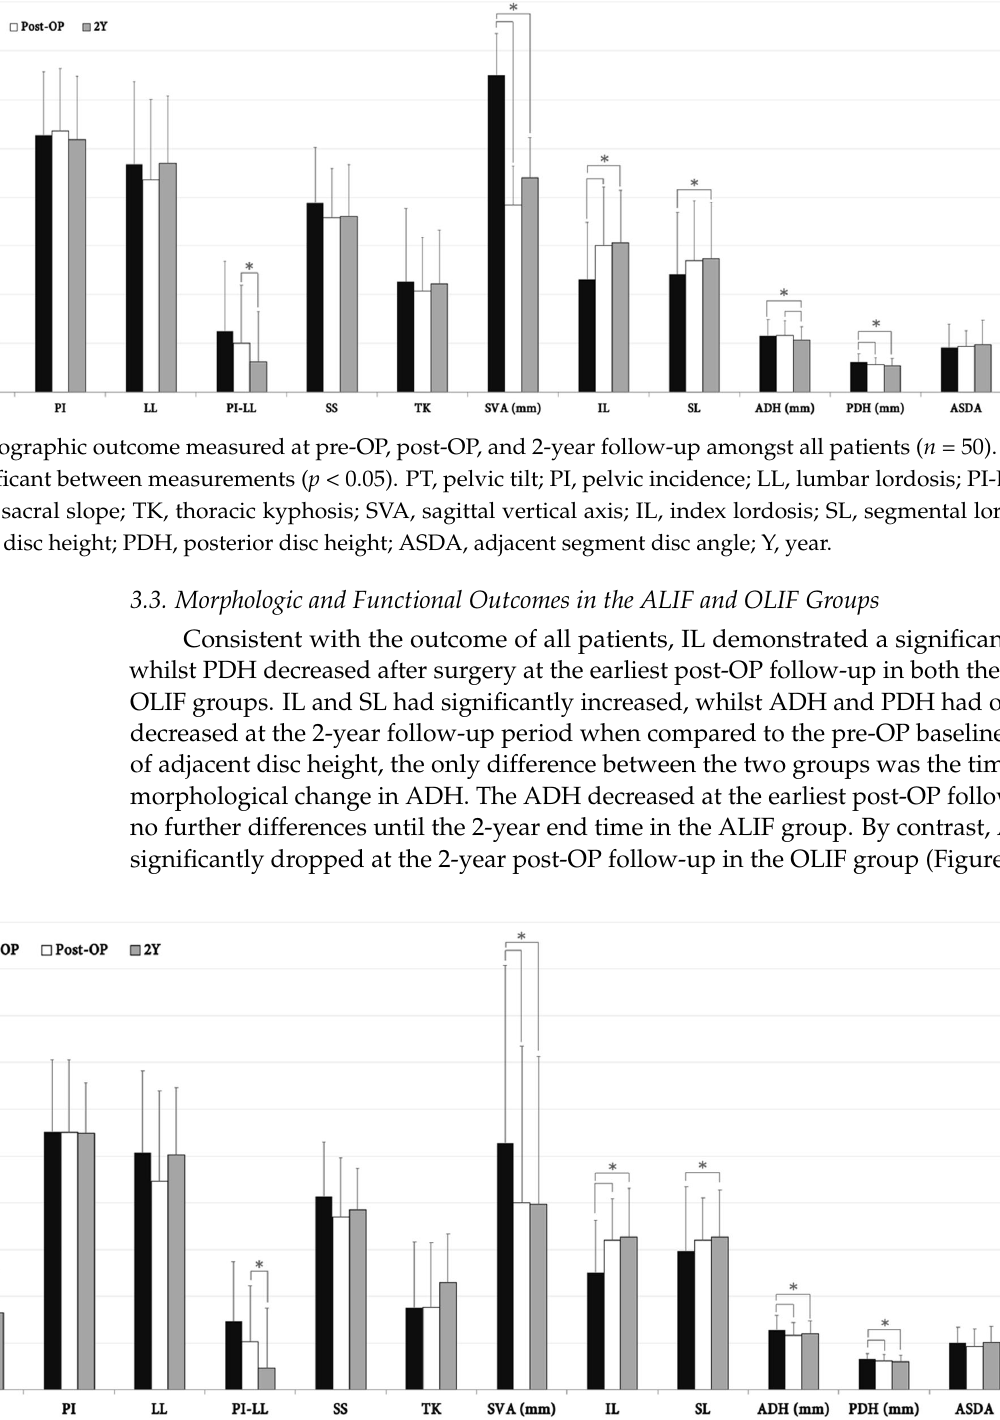
Figure 4. Radiographic outcome measured at pre-OP, post-OP, and 2-year follow-up amongst ALIF group ( n = 25). *, statistically significant between measurements ( p < 0.05). PT, pelvic tilt; PI, pelvic incidence; LL, lumbar lordosis; PI-LL, PI minus LL; SS, sacral slope; TK, thoracic kyphosis; SVA, sagittal vertical axis; IL, index lordosis; SL, segmental lordosis; ADH, anterior disc height; PDH, posterior disc height; ASDA, adjacent segment disc angle; Y, year.